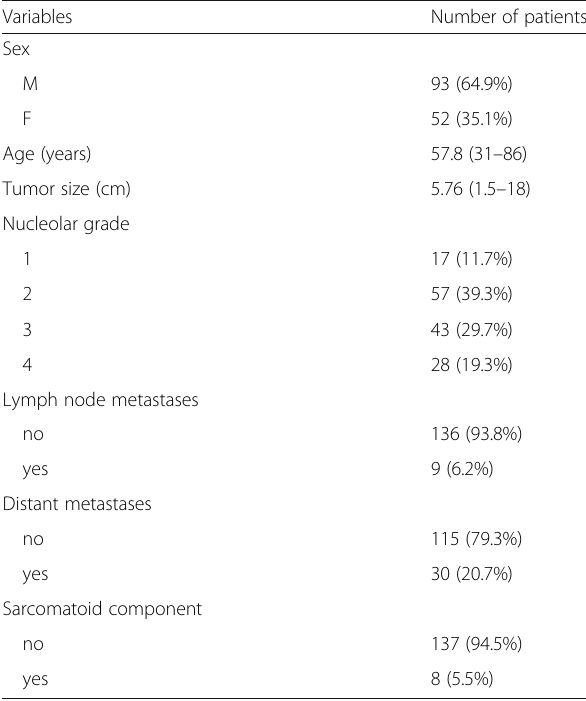
Table 1 Summary of the clinical and histopathological characteristics of 145 patients with ccRCC Variables Number of